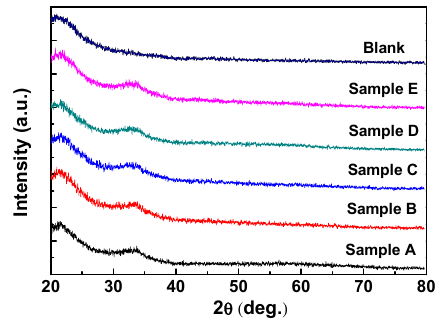
Figure 2. XRD spectrum measured from a blank quartz glass and Samples A, B, C, D, and E.